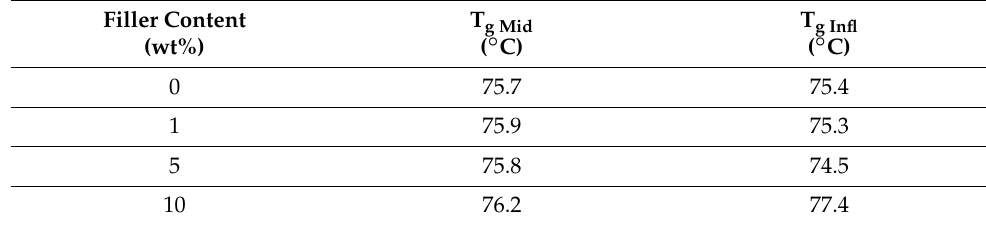
Table 3. The T g results of investigated